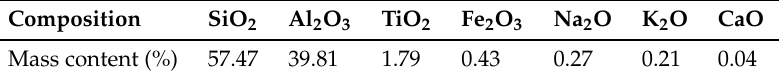
Figure 1. Particle size distribution ( a ) and XRD patterns ( b ) of the metakaolin powder. Table 1. Chemical components of the metakaolin powder.